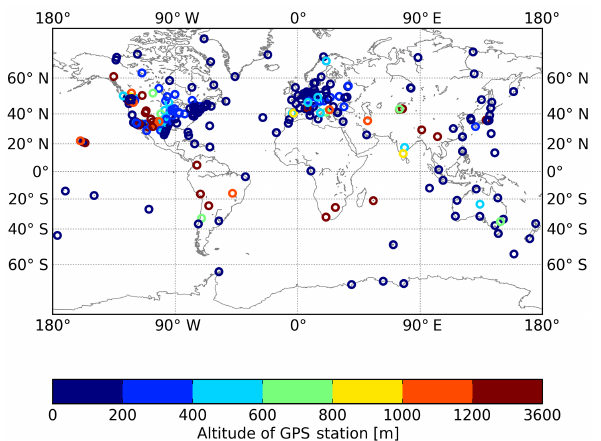
Figure 2. Boxplot of TCWV anomalies from the daily mean in per- centage for all stations and the period between 2003 and 2011. The range of the black boxes indicates the interquartile range (IQR), containing 50% of the data points (each point represents one sta- tions). The horizontal bar within the boxes represents the median; vertical bars (whiskers) indicate the reach of 95% of the data points; and grey pluses show outliers. Green line: mean daily cycle of TCWV of all high stations (greater than 800m altitude); orange line: Mean daily cycle of TCWV for coastal stations. See text for detailed description.